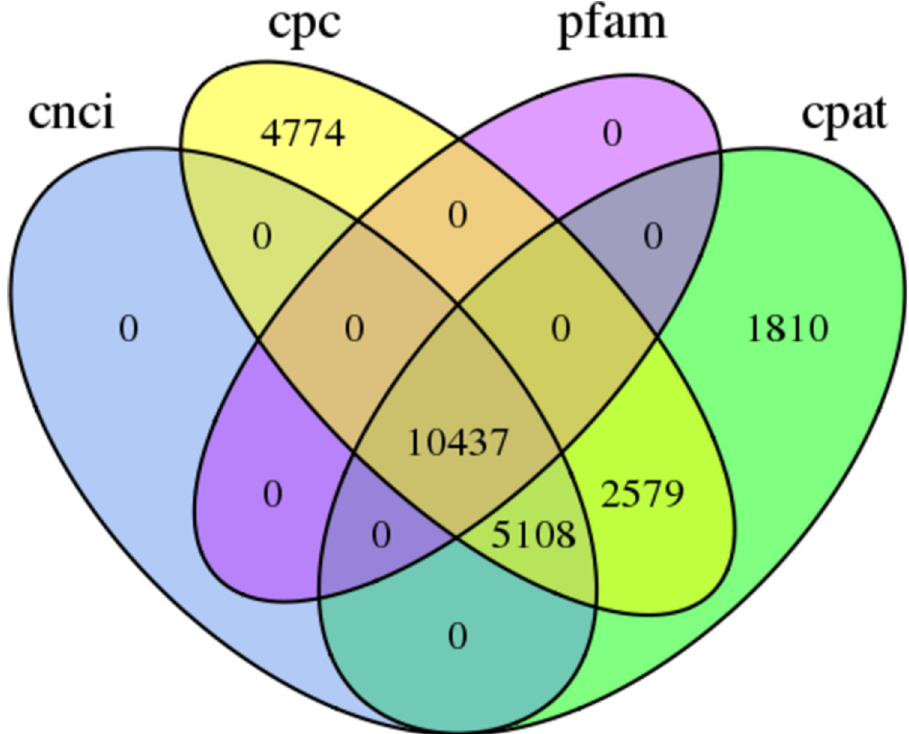
Fig 3. Candidate lncRNAs identified by CPC, CNCI, CPAT and Pfam.